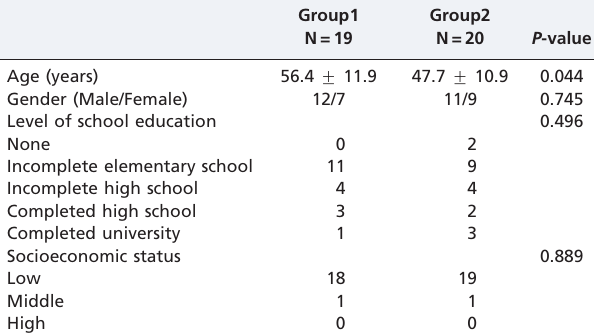
Table 1 - Demographic data and socioeconomic